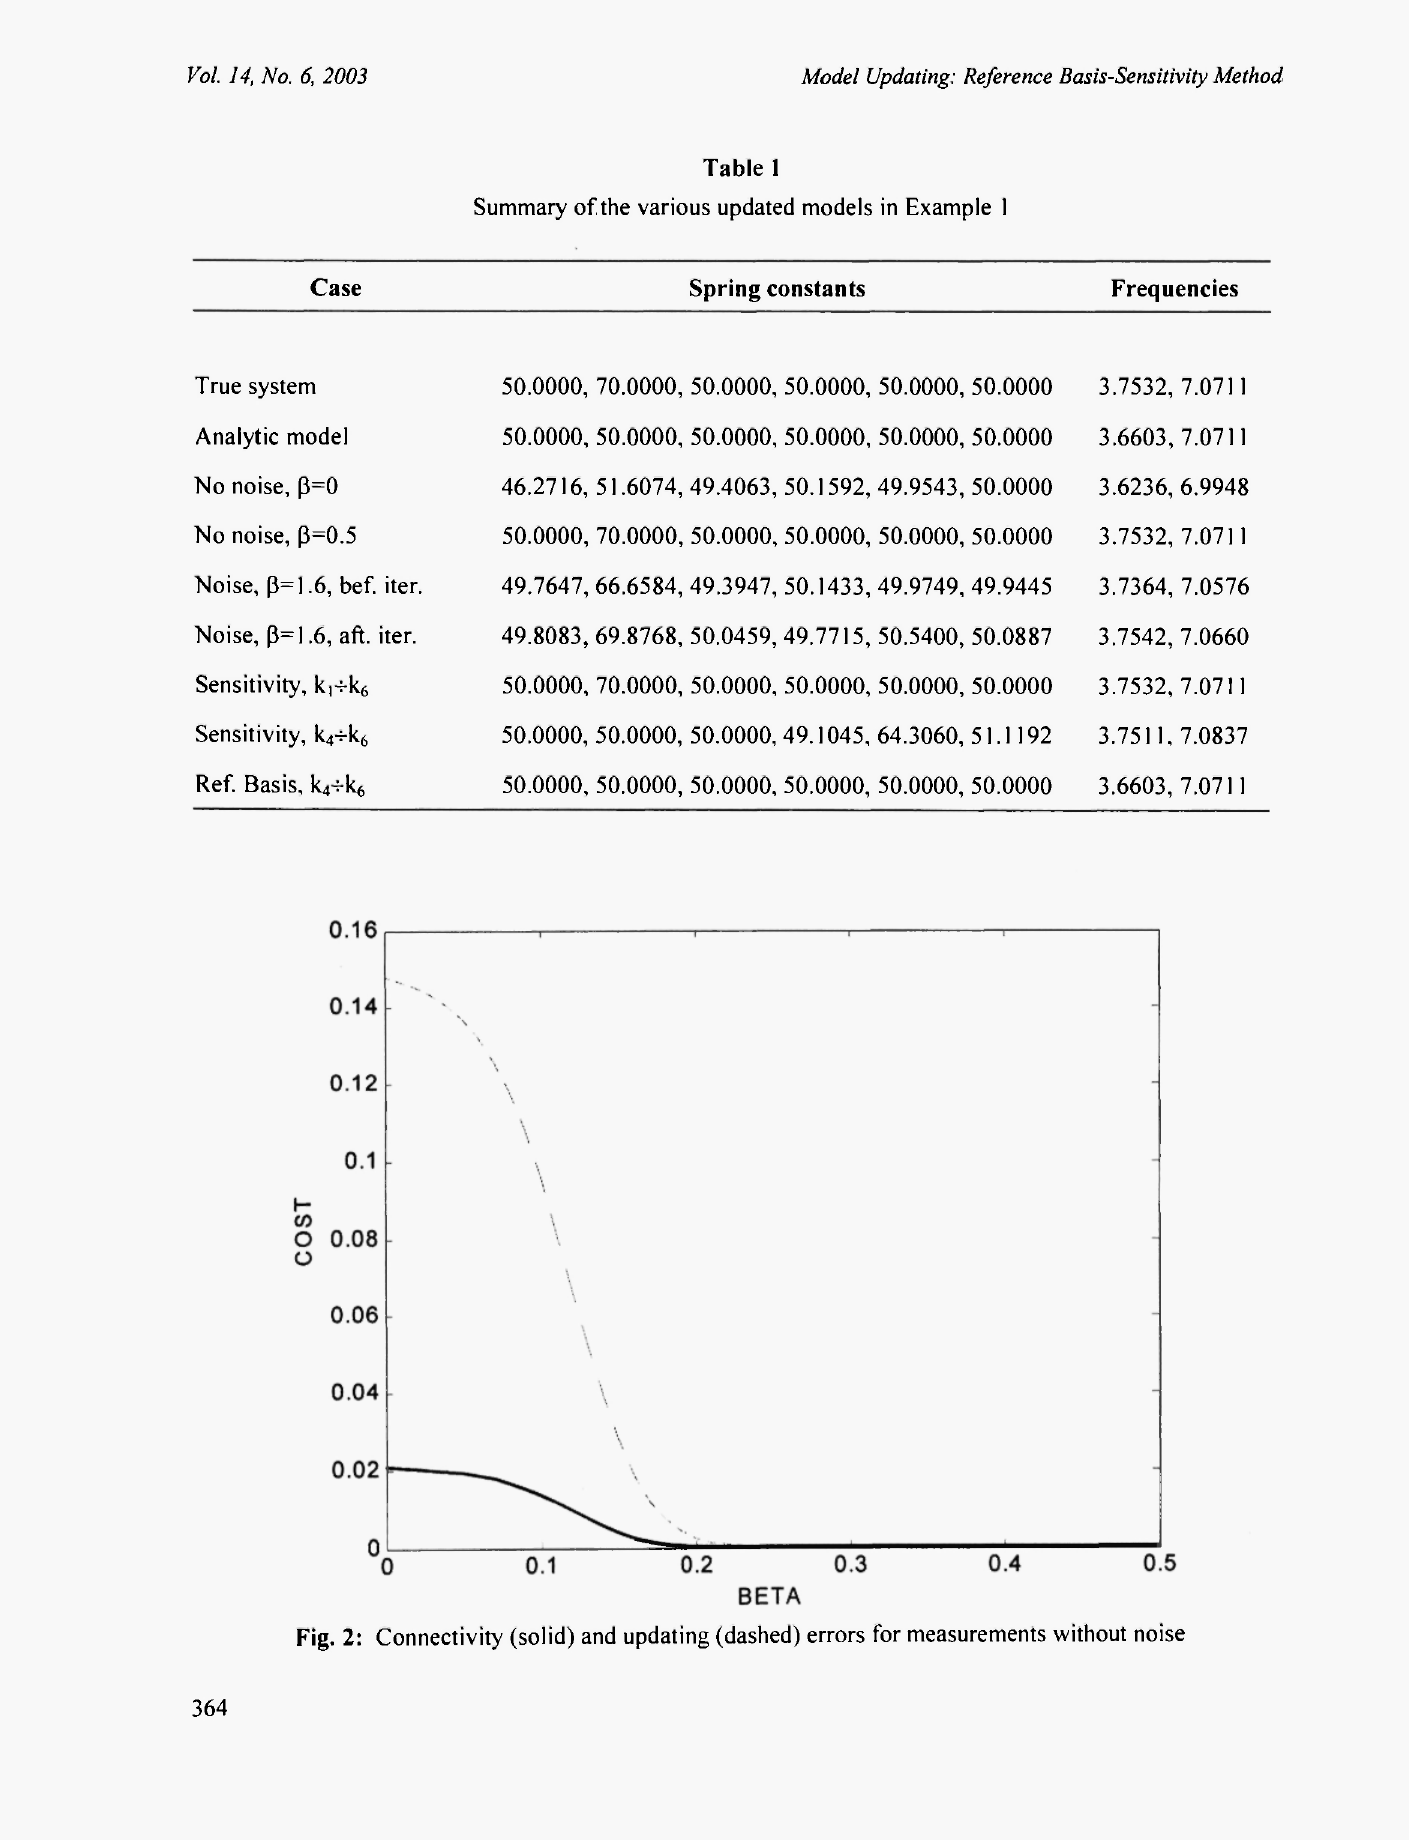
Fig. 2: Connectivity (solid) and updating (dashed) errors for measurements without